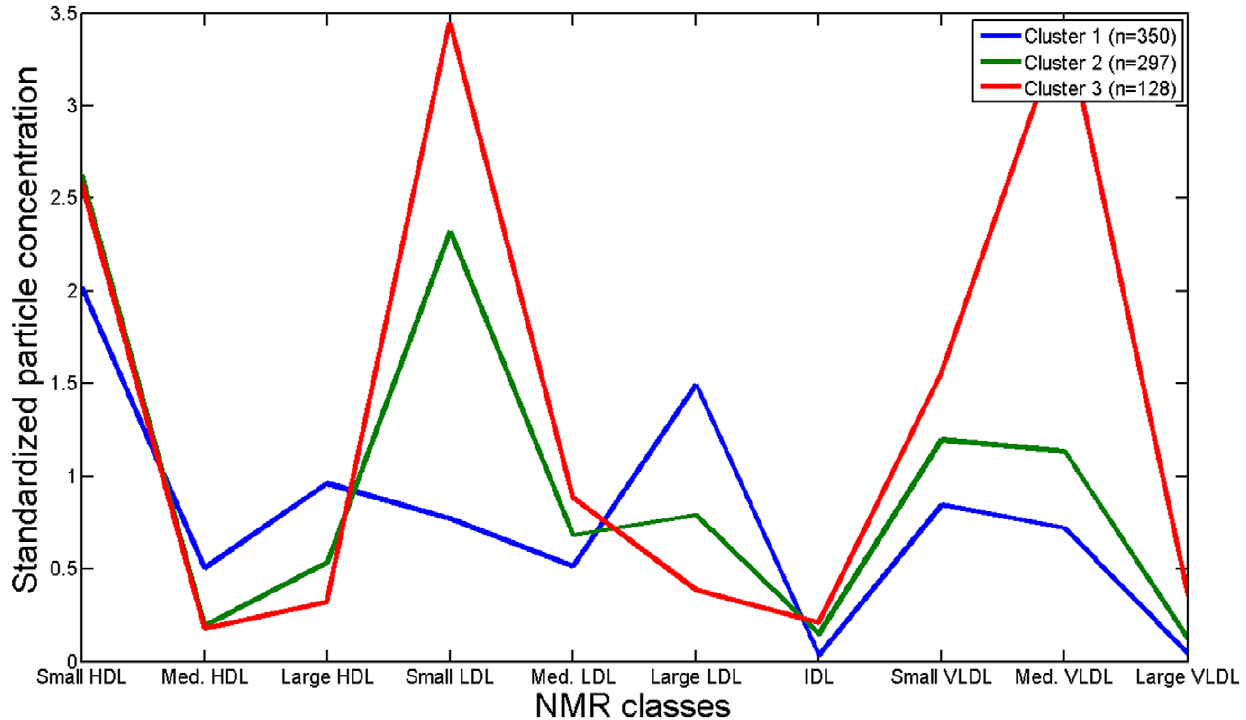
Figure 2. Mean standardized particle concentrations (unitless) of NMR lipoprotein subclasses in three subgroups based on K- means clustering. Particle sizes of the various subclasses were the same as described in Freedman, et al. [38].